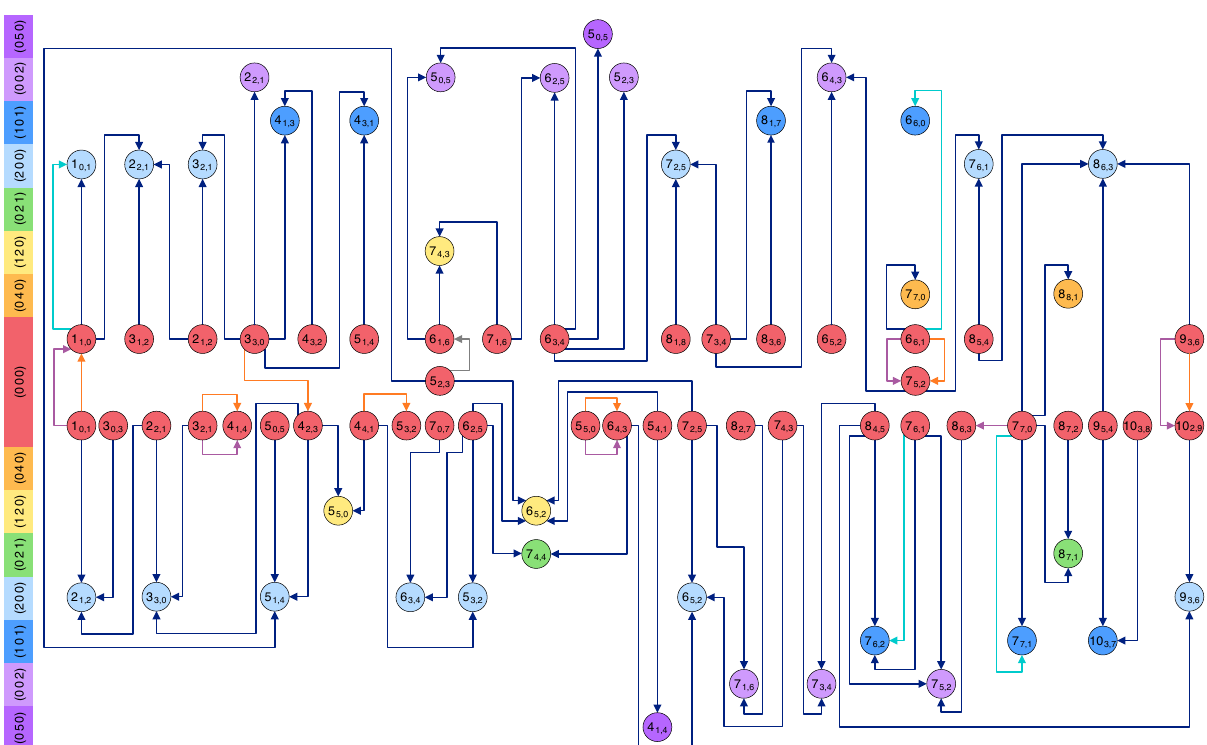
, where ( v 1 v 2 v 3 ) ; K a c corresponds to the asymmetric-top quantum numbers 70 . a ; K c rotational a ; K c